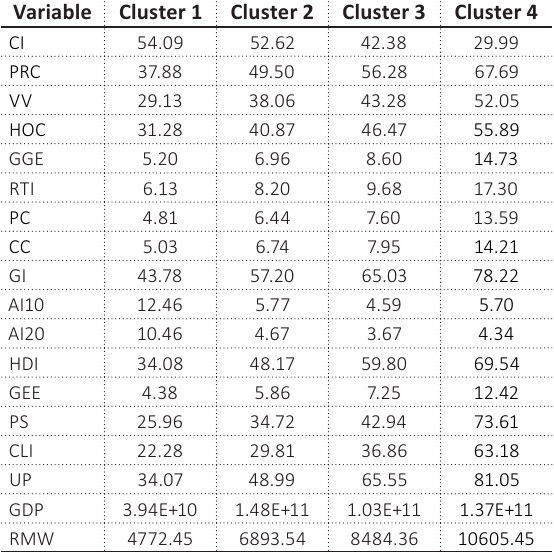
Table 3. Criteria for clustering the countries according to the factors of crimes against human life and health